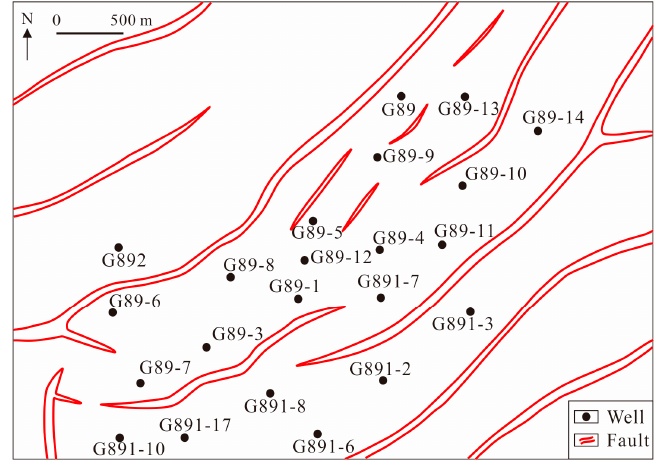
Figure 2. Top structure of sand group 1 of the lower section of the upper part of Es4 in Gao89-1 block.